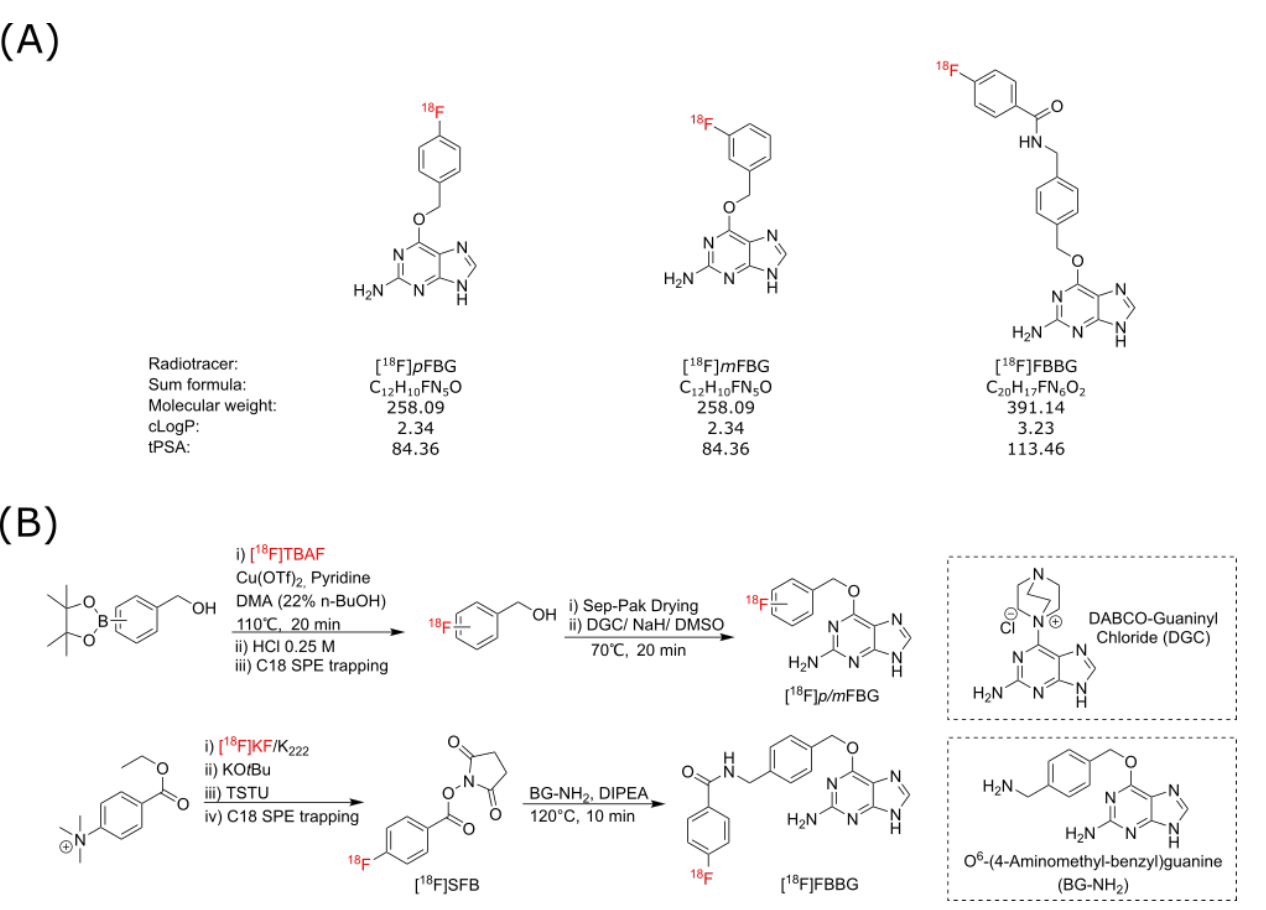
Figure 1. ( A ) Chemical structures and properties of [ 18 F] p FBG, [ 18 F] m FBG, and [ 18 F]FBBG. ( B ) Schematic representation of the individual radiosyntheses of the three radiotracers. Both [ 18 F] p FBG and [ 18 F] m FBG were synthesized from the [ 18 F]fluorobenzyl alcohol synthon via the same general radiosynthetic procedure. [ 18 F]FBBG was prepared by conjugation of [ 18 F]SFB to BG-NH 2 .